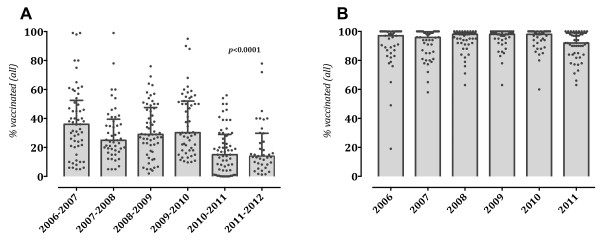
Seasonal influenza (Panel A) and HBV (Panel B) vaccination coverage among HCWs in Croatian hospitals, stratified by season/year. Each dot represents one hospital while bars represent the medians with IQRs. Statistical significance was calculated using the Kruskal–Wallis and post hoc multiple comparison tests. In (Panel A), significant decreases in 2010–2011 and 2011–2012 post-pandemic vaccination coverage is seen in comparison to the four pre-pandemic seasons. Meanwhile, HBV vaccination coverage was stable during the period studied (p = 0.07) (Panel B).